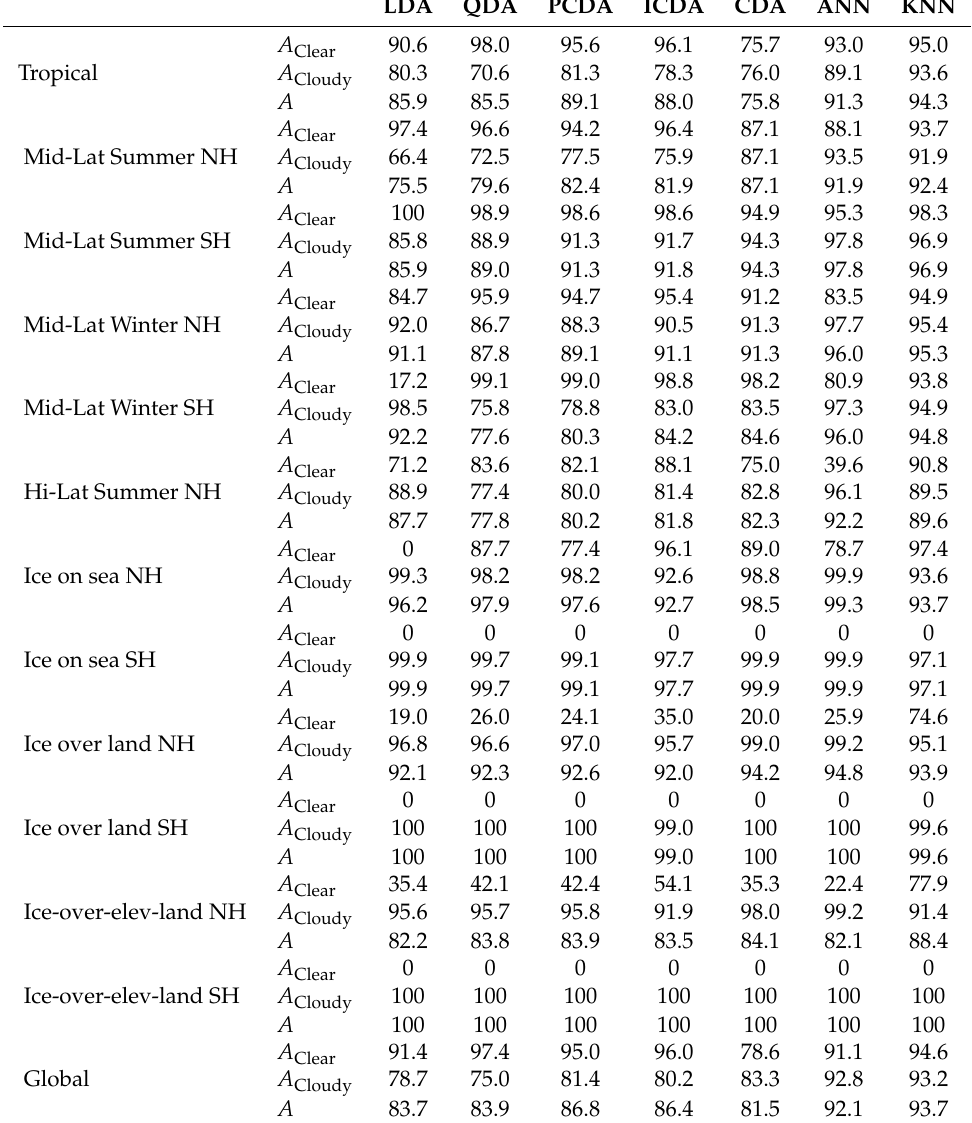
Table 9. Accuracy indicators A , A Clear and A Cloudy of classification methods of Section 3 when validation is made on the full dataset and classifications are separate for each climatic zone of Section 2.6. Percentage values are reported for the entire dataset (row Global) and for the different climatic